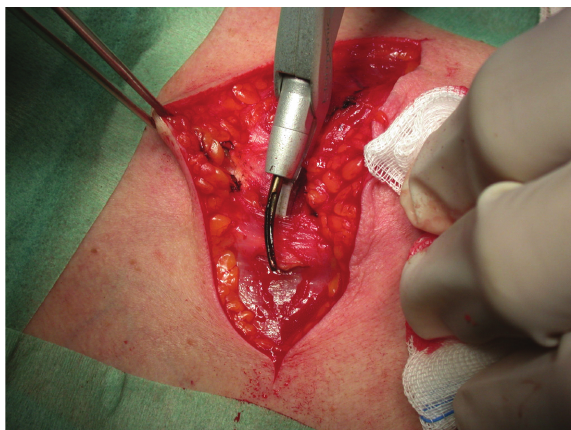
Figure 3: Dissection of the muscle platysma with Focus Ultracision Harmonic Scalpel.